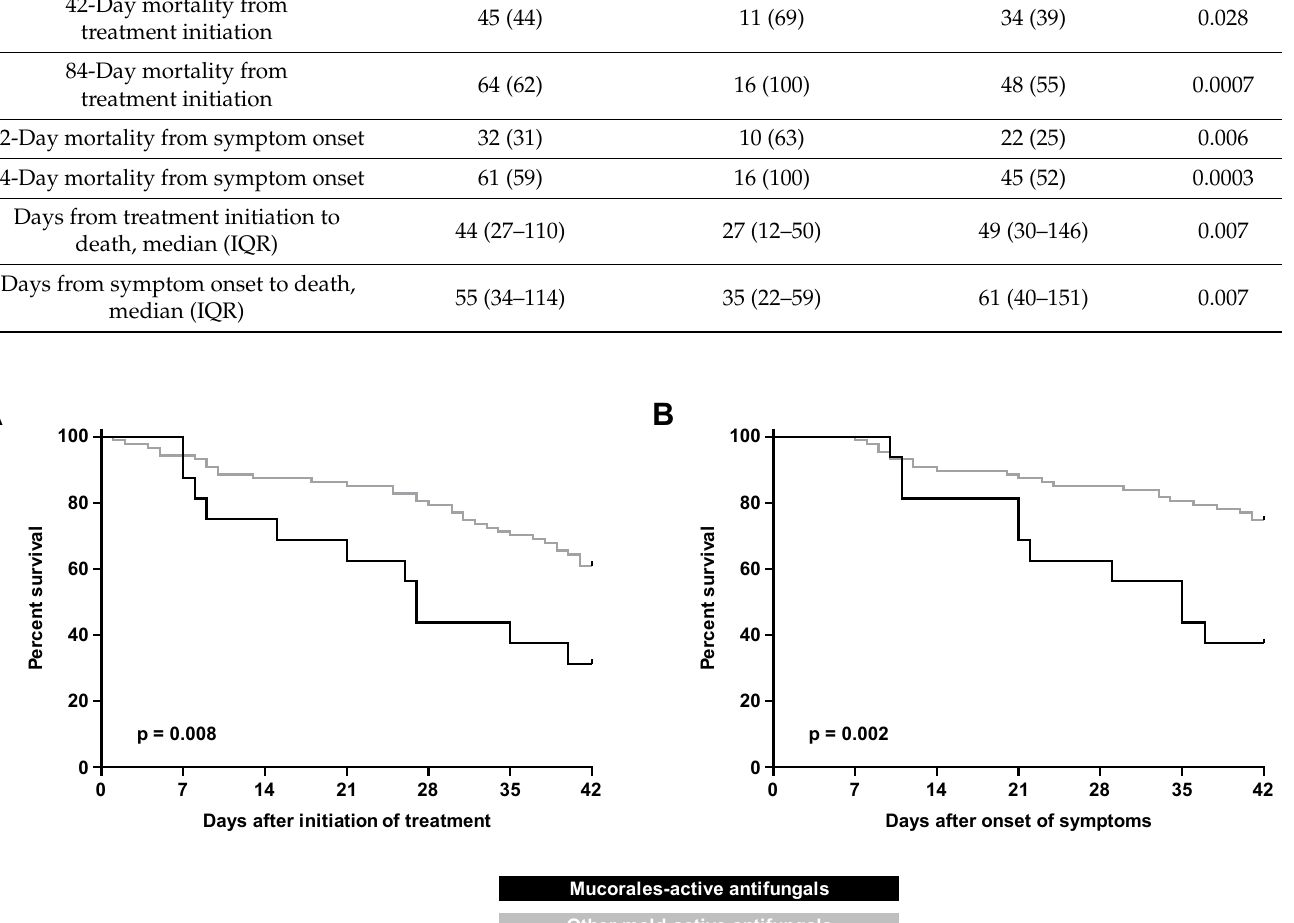
Figure 1. Kaplan–Meier curves of progression to 42-day mortality in patients with hematologic malignancy and recipients